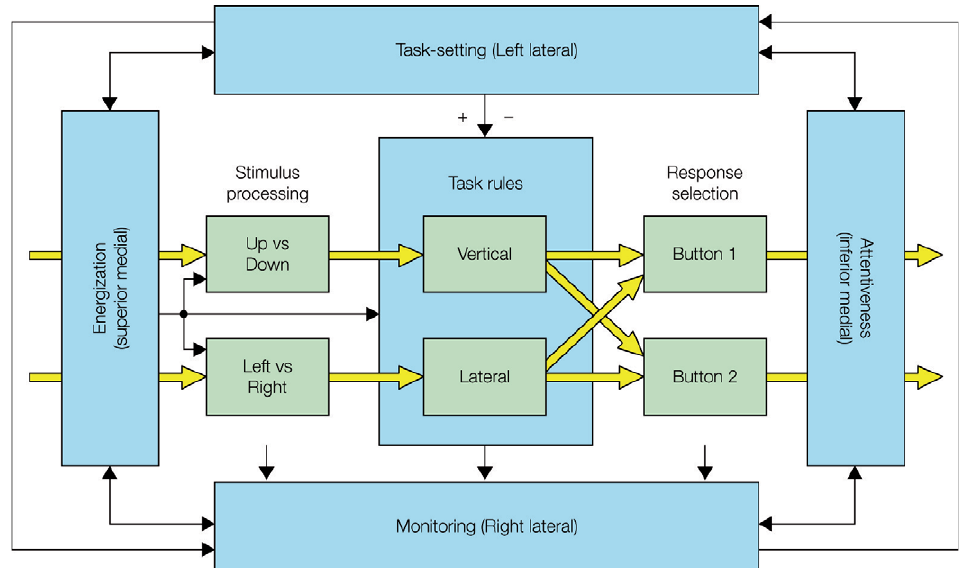
Figure 2 | The conceptual framework of the paper based on the Supervisory System framework (Shallice and Burgess, 1996; Stuss et al., 1995). The inner green boxes and yellow arrows represent on-line processes which (following learning) would be realised in contention scheduling. The outer blue boxes and arrows represent supervisory control processes. These include (in the early stages of learning) task rules operating as explicit if-then contingencies. The four patient groups discussed – left lateral, right lateral, superior medial and inferior medial – are held to have impairments in different supervisory